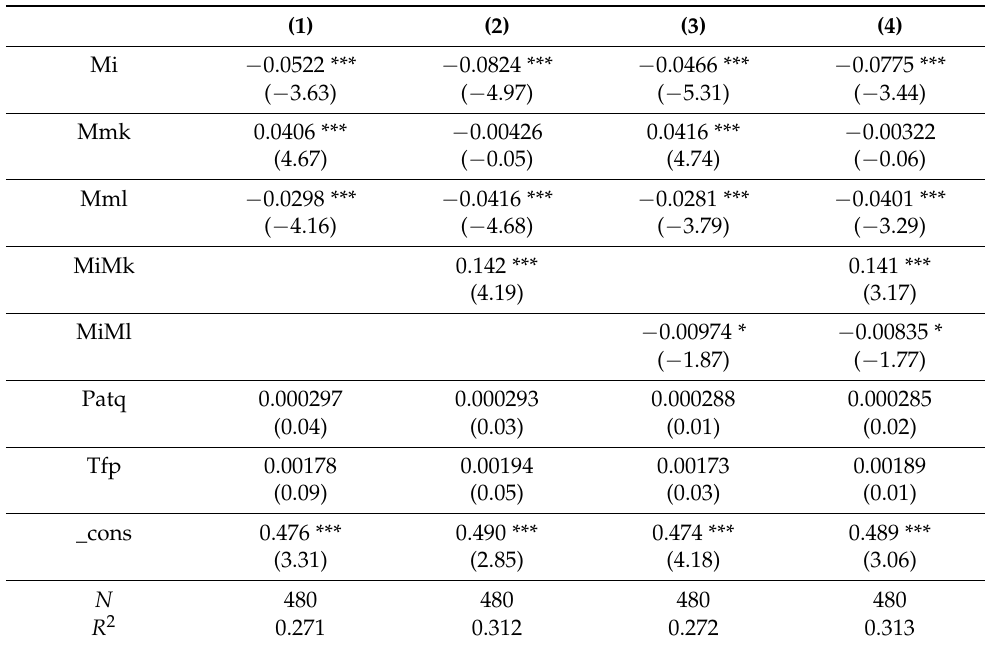
Table 6. Mismatch of UCLU and misallocation of labor and